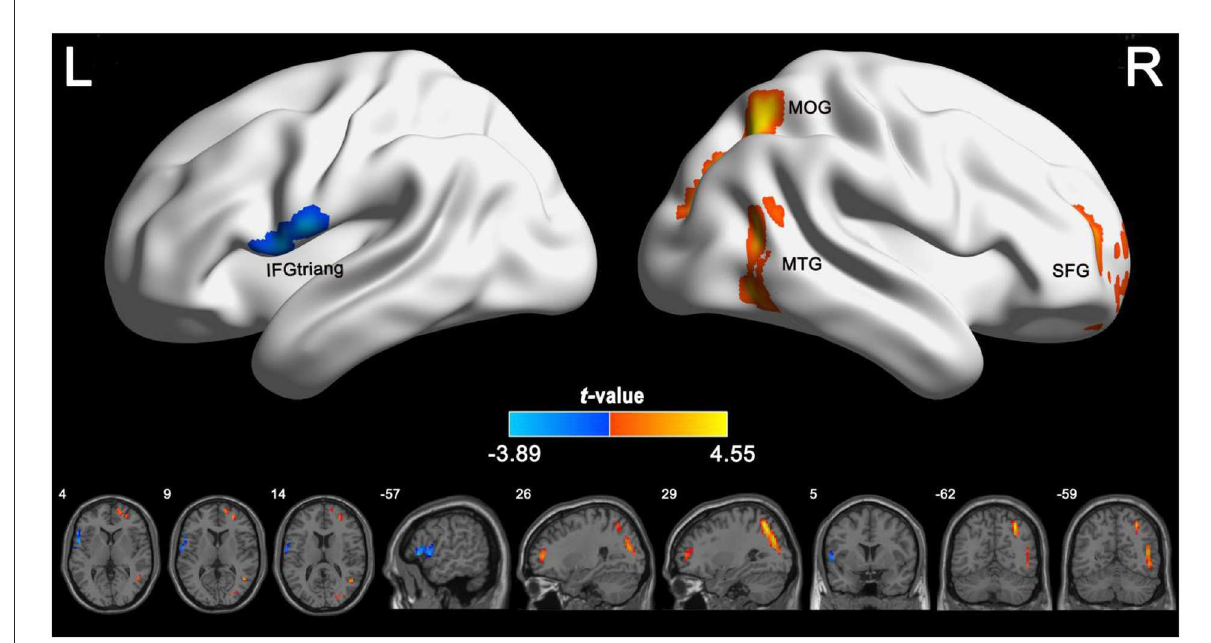
FIGURE2 Group differences in CBF between IGE patients and healthy controls. The independent two-sample t test was conducted between the IGE group and the healthy control group. All results were corrected for multiple comparisons (GRF-corrected, P < 0.05). The cold colors denote significantly decreased CBF in the IGE patients. The warm colors denote significantly increased CBF in the IGE patients. CBF, cerebral blood flow; GRF, Gaussian random field; IGE, idiopathic generalized